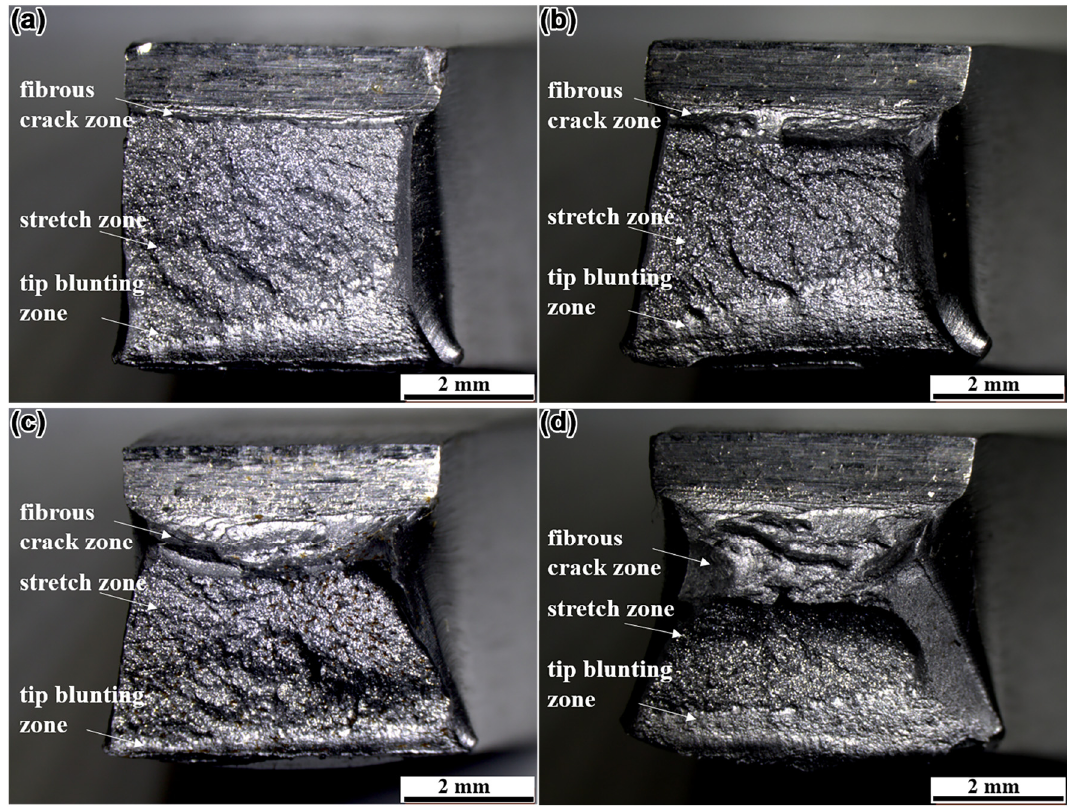
Figure 7. The macroscopic morphology of fracture after impact test at the distance of 2 mm from the fusion line at − 20 °C,